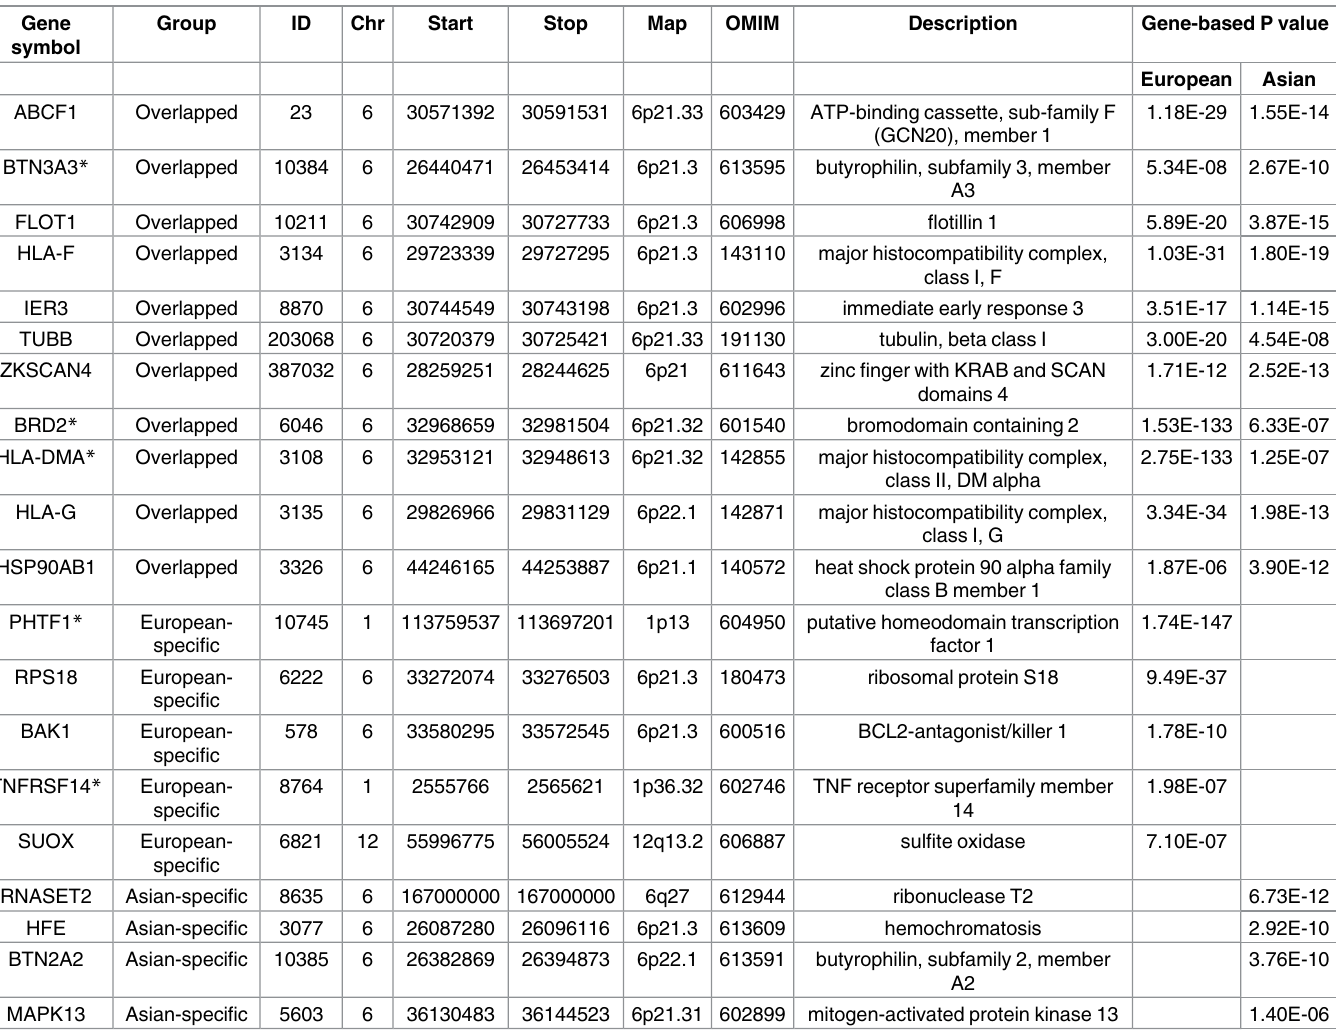
Table 1. The 20 ‘highly verified’ RA-associated genes newly identified by gene-based association